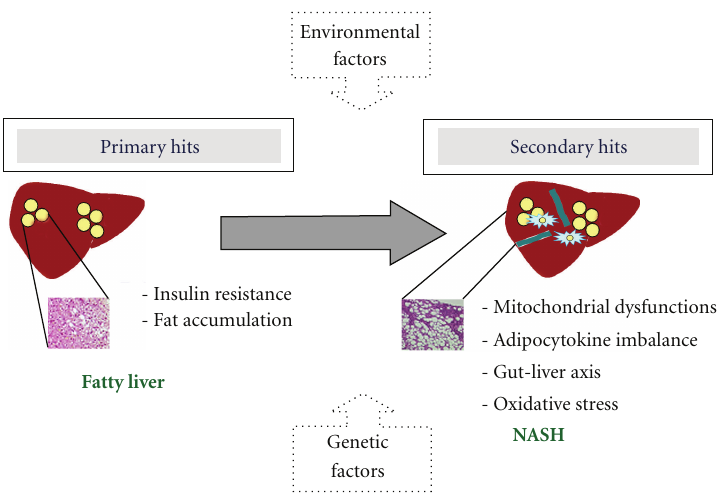
Figure 2: Simplified representation of NASH pathogenesis. NASH, nonalcoholic